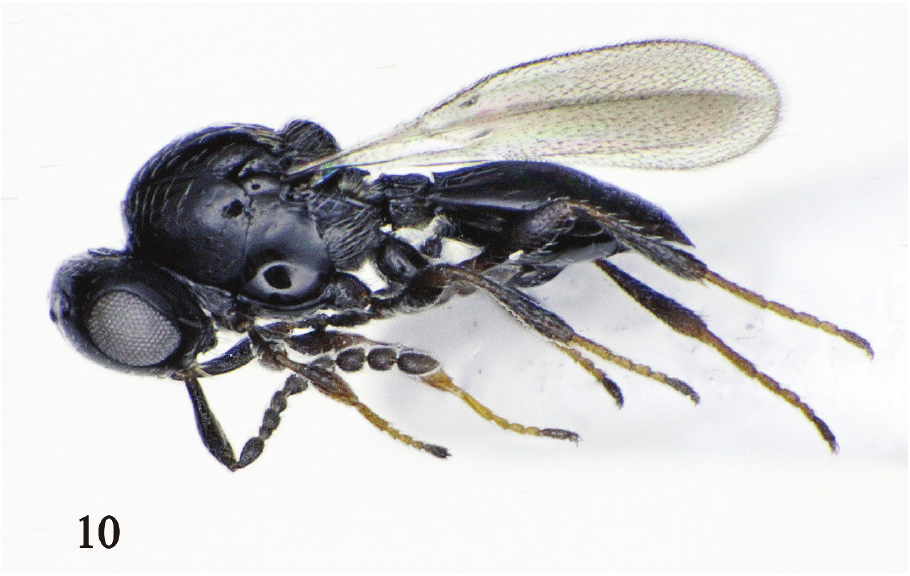
Figure 10. Holotype female of Platygaster urniphila